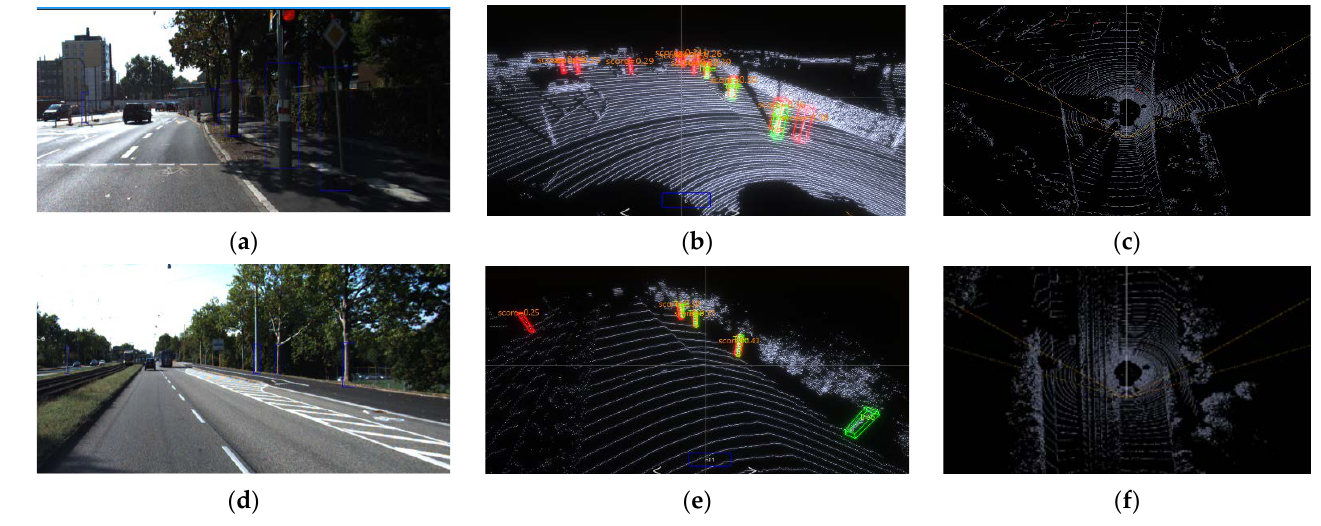
Figure 8. Test results of PointPillars. ( a ) Camera image; ( b ) 3D view of the ( a ); ( c ) a bird’s eye view of ( a ); ( d ) camera image; ( e ) 3d view of the ( d ); ( f ) a bird’s eye view of ( d ).